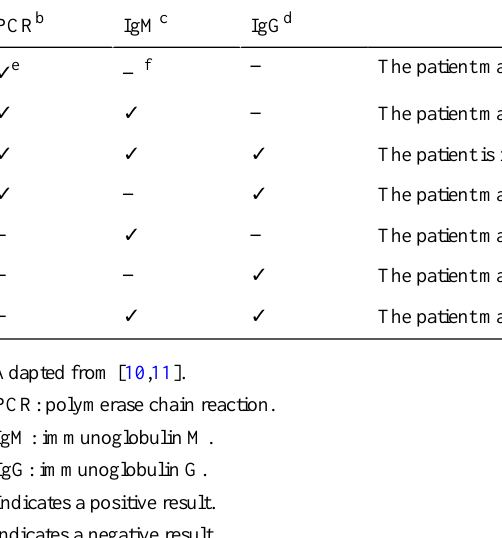
Clinical SignificanceTest